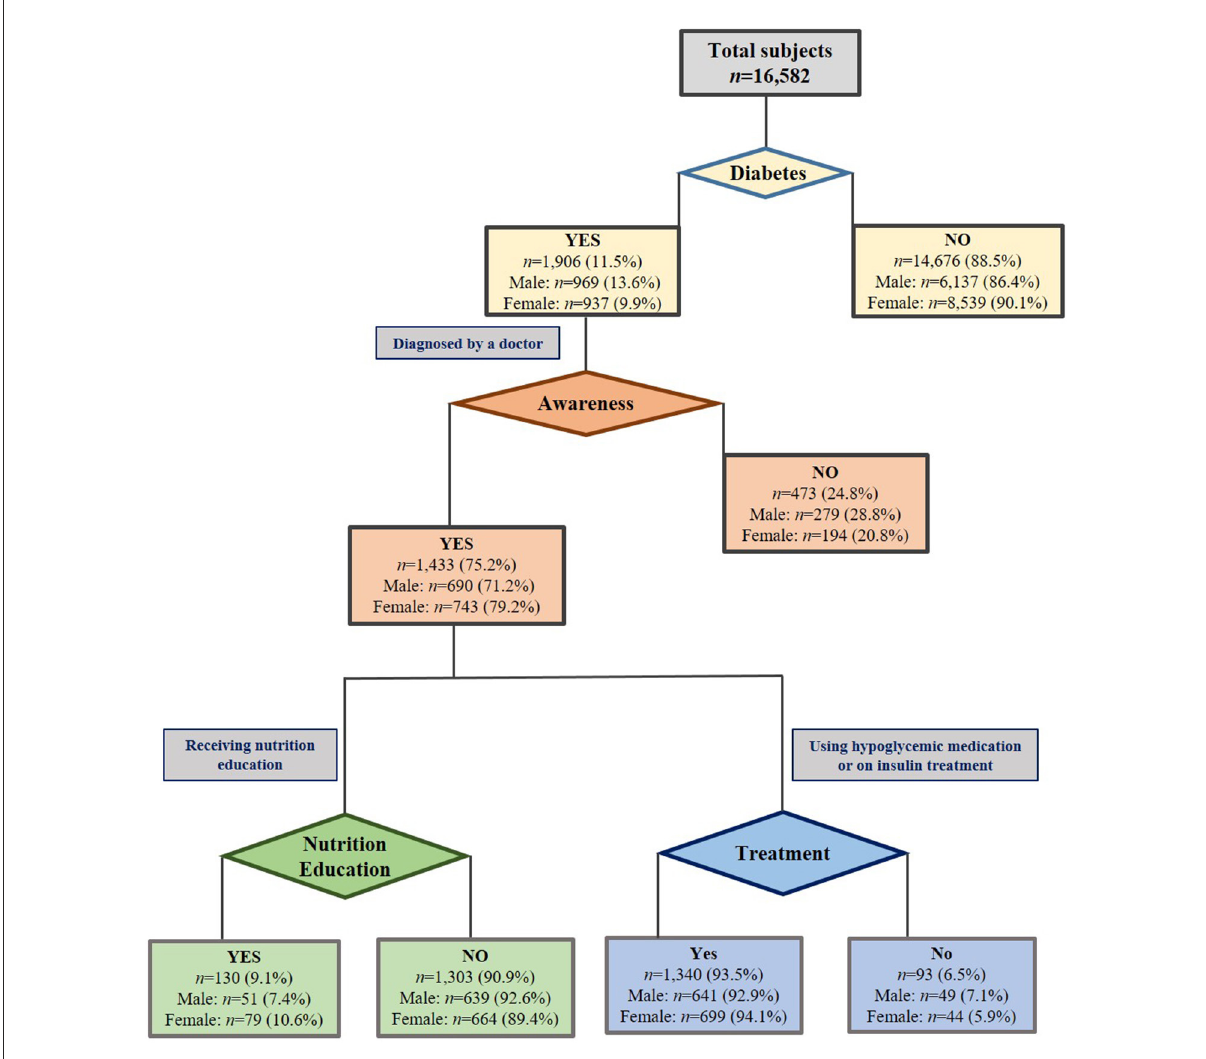
FIGURE1 Distribution of individuals with diabetes in Korean adults.